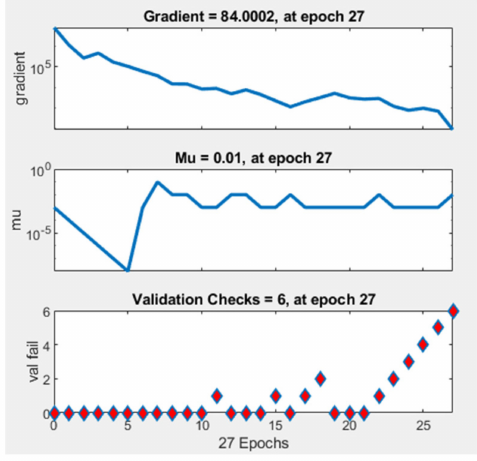
Figure 5. Early stopping strategy for the ANN